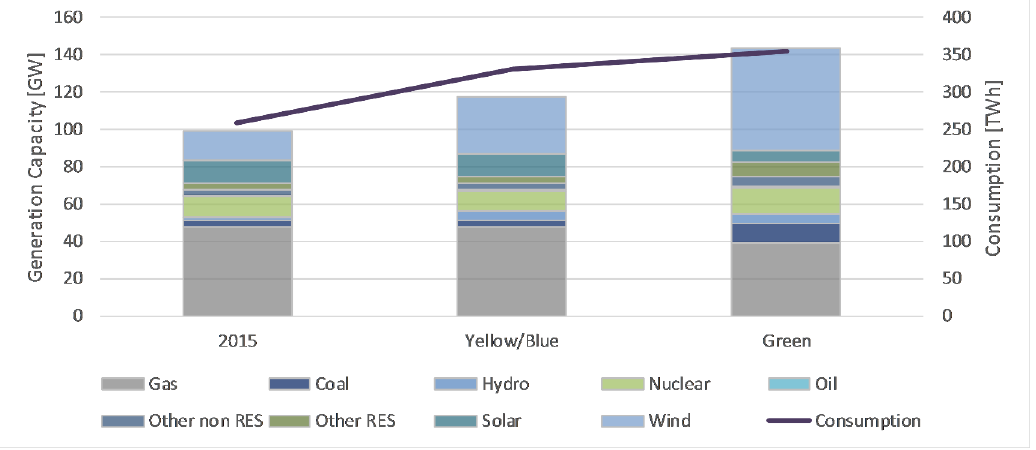
Figure 1. Assumptions on changes in installed capacity. Source: Own compilation based on [60] and [11].